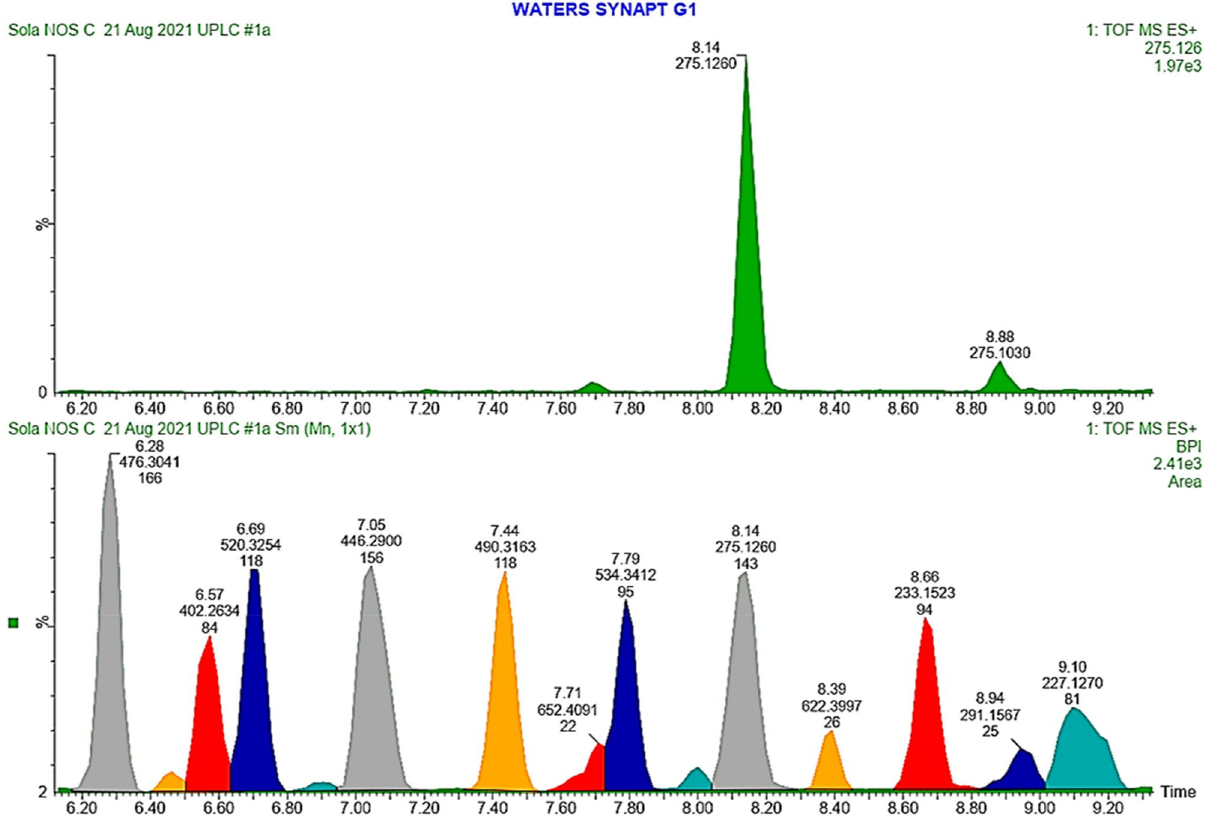
Figure 5. UPLC-ESI–MS fingerprint of ZF 52 EtOAc extract.